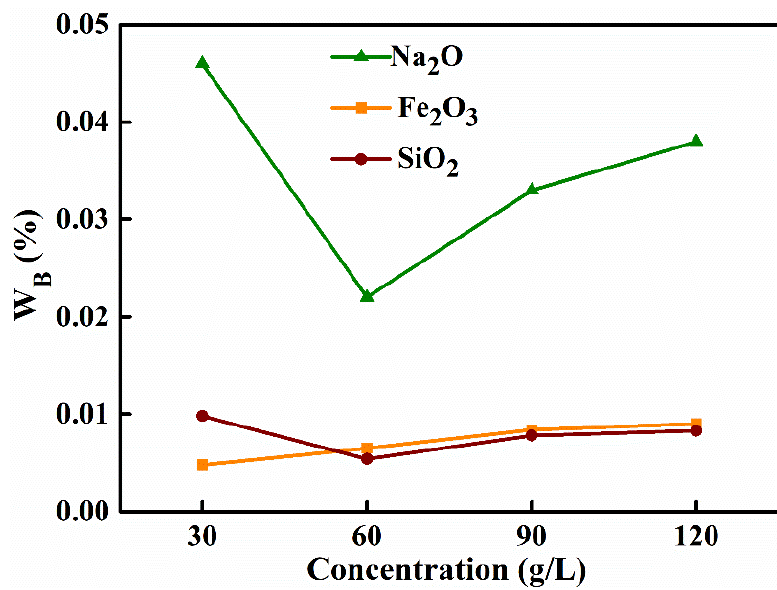
Figure 1. Effect of initial concentration of NaAl(OH) 4 solution on the mass ratio of MA.